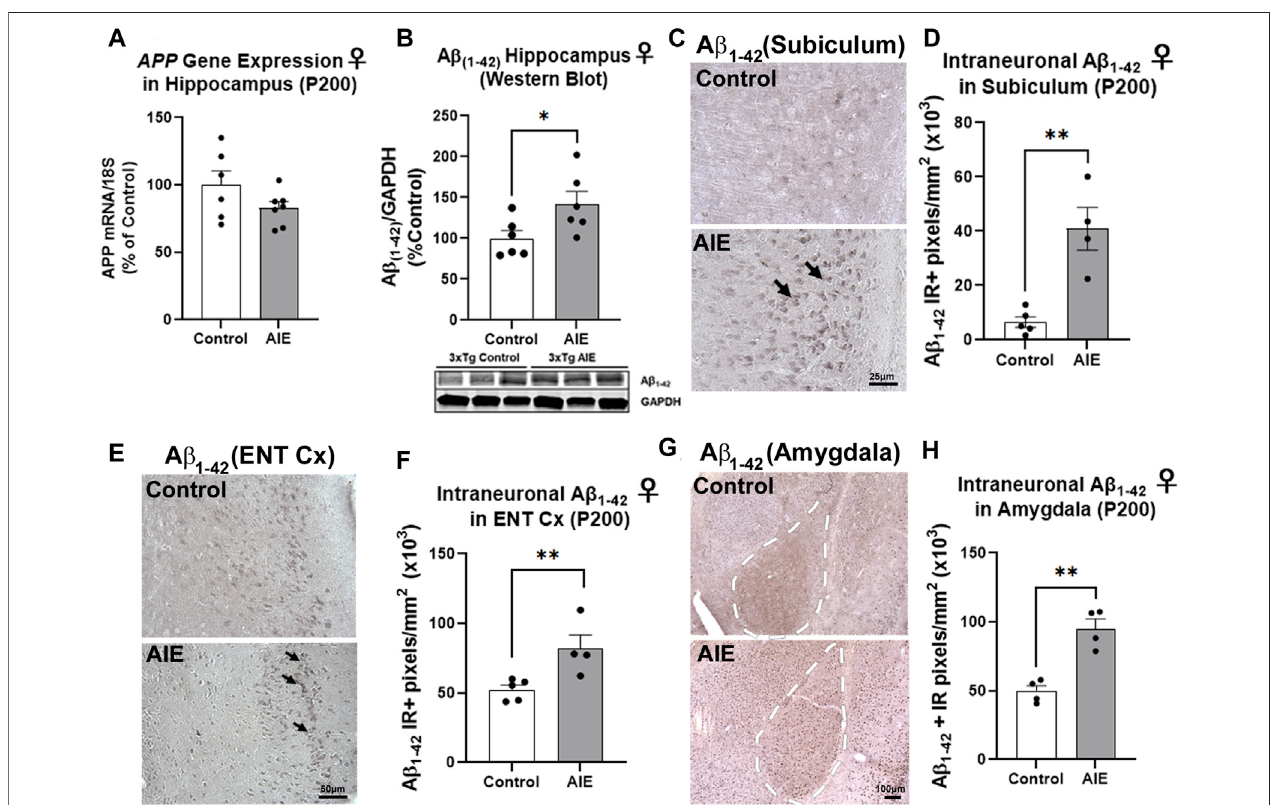
FIGURE 2 | AIE increases amyloid pathology in adult female 3xTg-AD. 3xTg-AD mice received either AIE (5 g/kg/day, i.g., 2-days on 2-days off, P25-55) or water gavageandwereassessedforamyloidpathologyatP200. (A) RT-PCRforhumanamyloidprecursorprotein(APP)transgeneatP200foundAIEdidnotsigni fi cantlyalter APP gene expression ( p = 0.14). N = 6 control, 7 ethanol (B) Western blot found AIE caused a 42% increase in neurotoxic A β 1 – 42 protein in female hippocampus ( *p < 0.05, Sidak ’ s post-test). (C) Representative image of immunoreactive (+IR) intraneuronal A β 1 – 42 staining in the subiculum of control and AIE-treated subjects